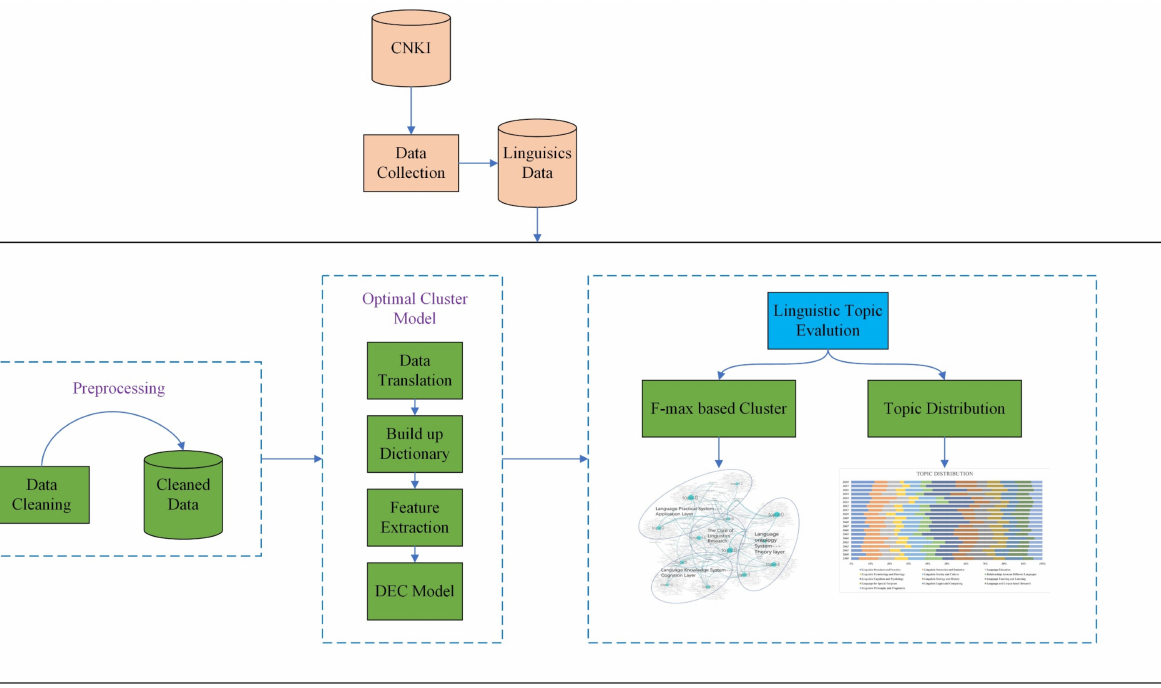
Figure 6. The research procedure of data